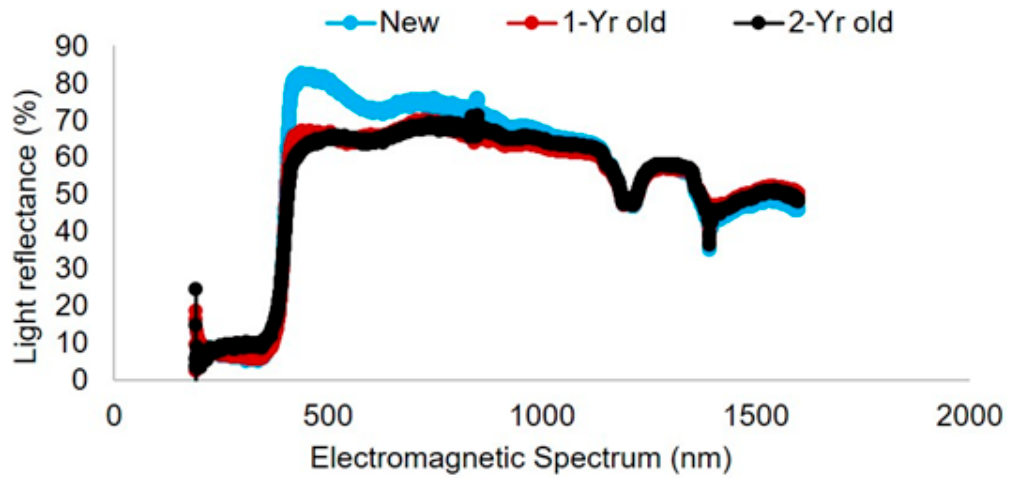
Figure 6. Light reflectance spectrum of the white color base of pan trap platform used in this study. Light reflectance spectrum of new (New), one-year-old (1-Yr old), and two-year-old (2-Yr old) platforms is presented.